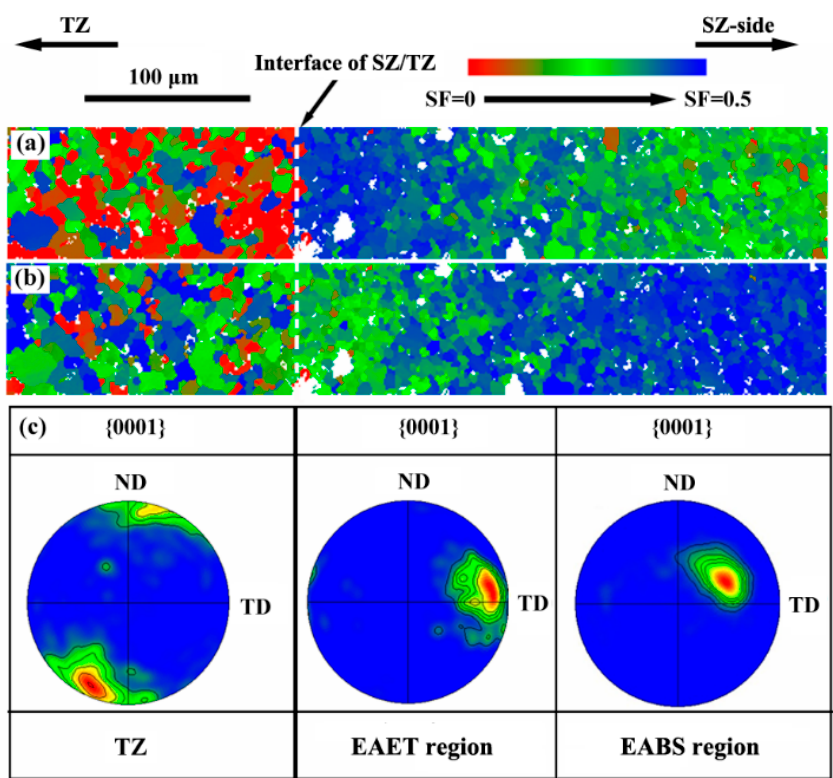
Figure 5. SF maps at the SZ/TZ interface of FSW AZ31 alloy: SF maps for extension twinning ( a ) and basal slip ( b ); and {0001} pole figures in micro-regions near the SZ/TZ interface [84] ( c ).